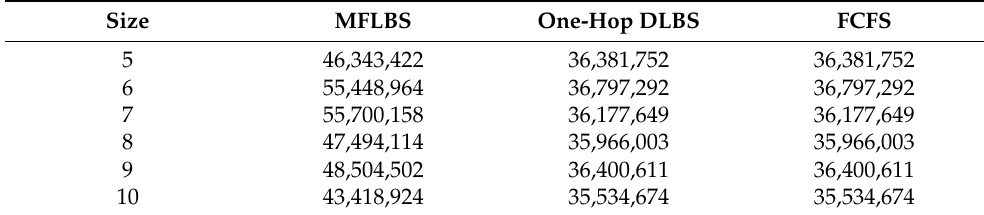
Table 7. Average throughput (MB) in mesh topology under uniform pattern.